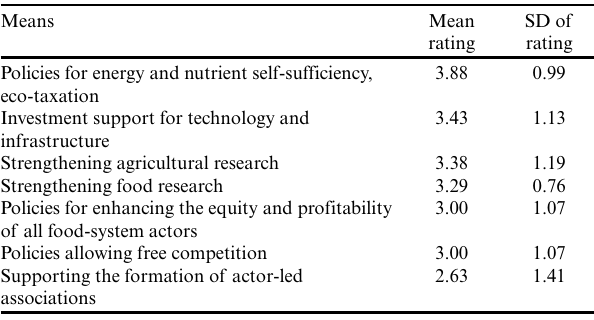
Table 4 . Delphi panel views on the usefulness of different means, suggested in the brainstorming session and by Delphi round 1 participants, for supporting food-system resilience in Finland. The mean values and standard deviations are based on Delphi round 2 rankings on a scale from 1 (total disagreement) to 5 (total agreement) by the panelists on the usefulness of the means. n =